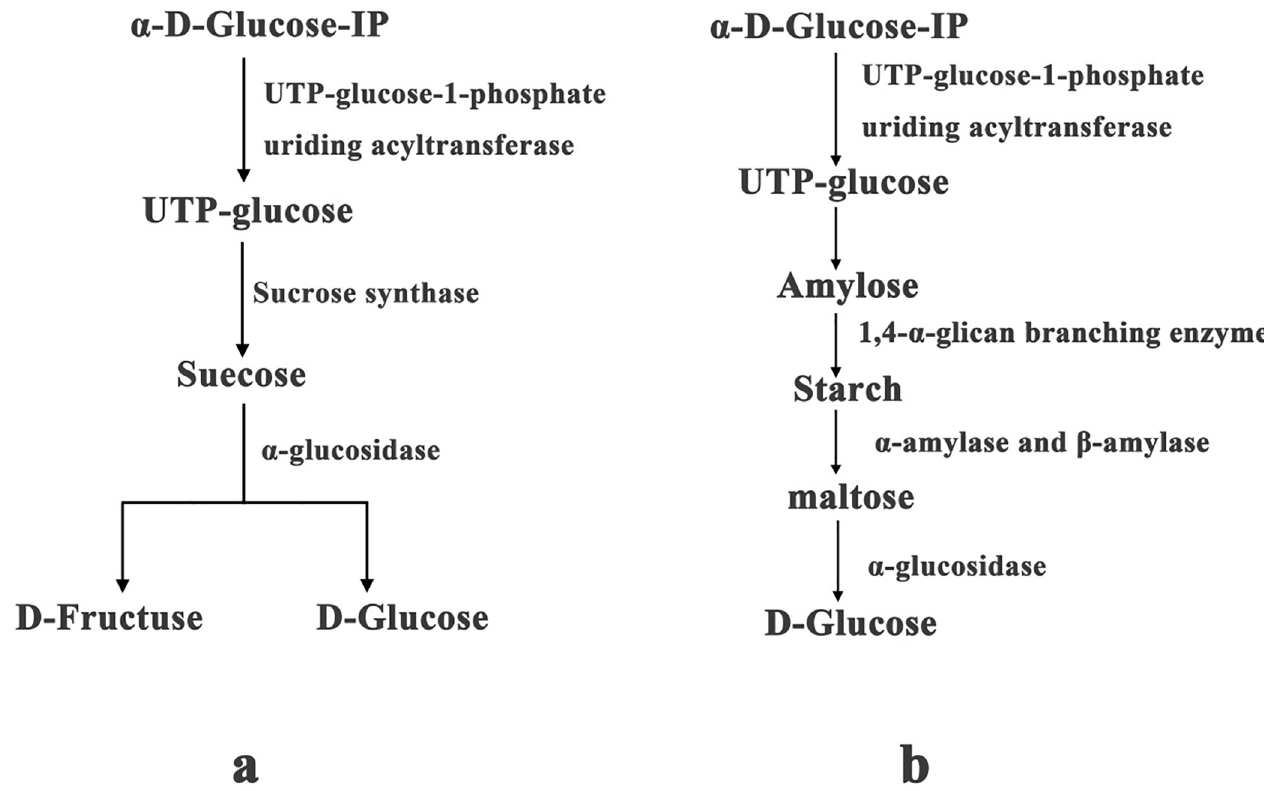
Fig 6. Changes in leaf starch and sucrose pathway gene expression under drought stress. Altered expression of genes involved in sucrose metabolism (a) and starch metabolism (b).